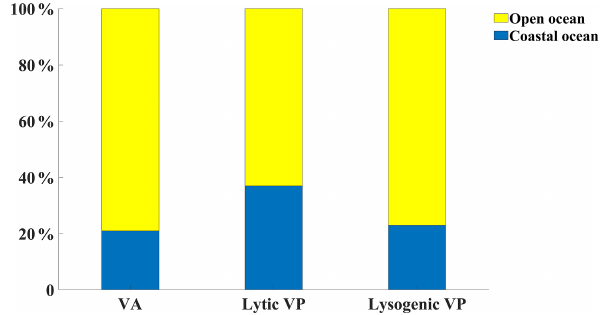
Figure 5. The fraction of viral abundance (VA), lytic viral produc- tion (VP) and lysogenic VP data points in coastal versus in open